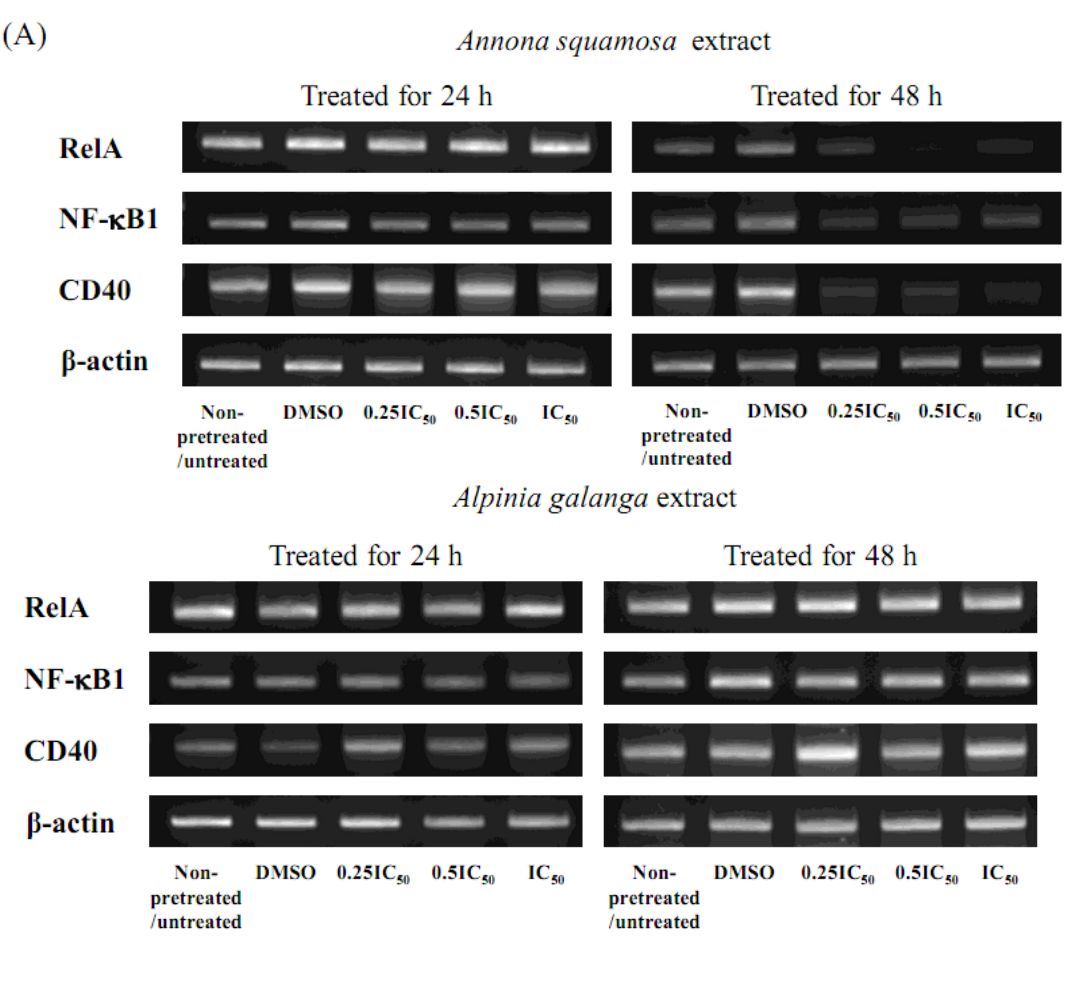
Figure 3. The effect of Thai medicinal herb extracts on the expression of mRNA transcripts of NF- κ B signaling network biomarkers in proinflammatory cytokines-non- pretreated HaCaT cells treated with increasing concentrations of each herbal extract type for either 24 h or 48